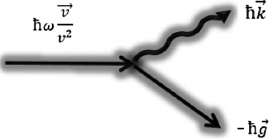
FIG. 1. PXR represented as pseudophoton decay with momen- tum ℏ ω =v in a photon and a susceptibility wave.